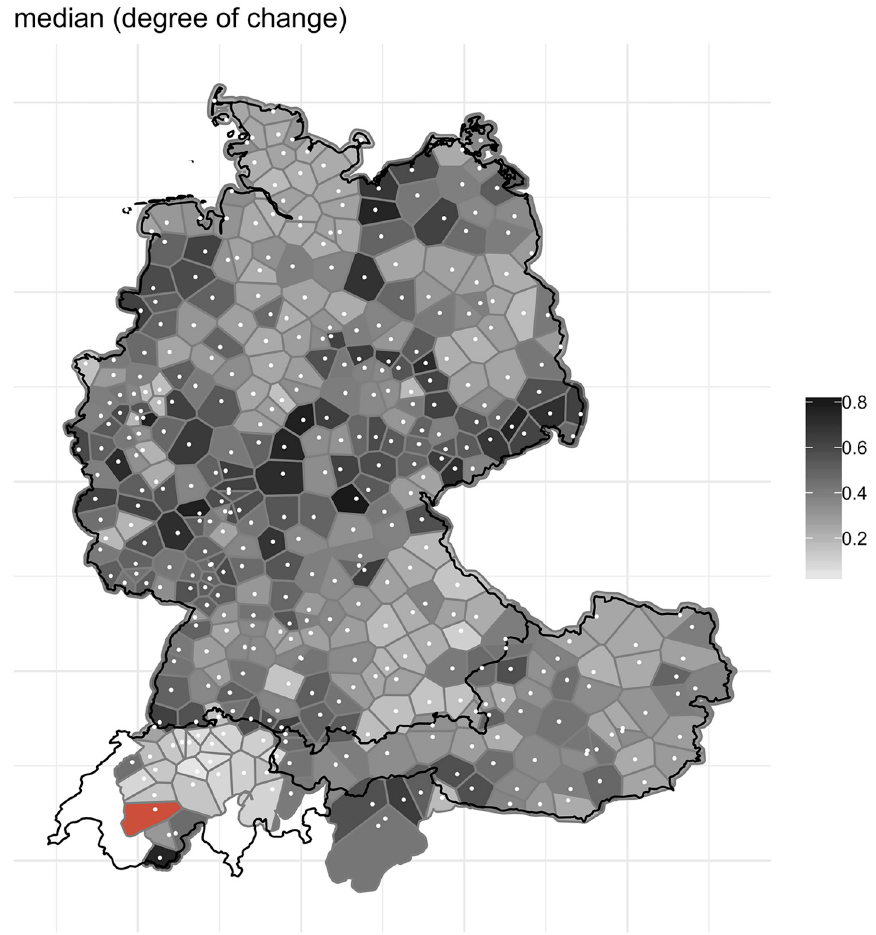
Fig 14. Median degree of change aggregated across 14